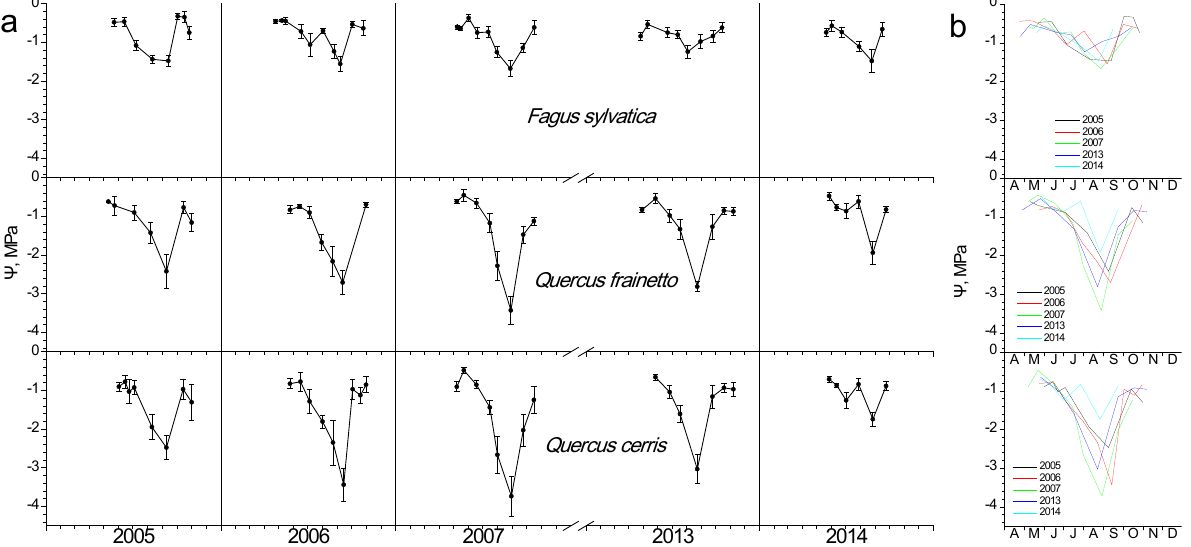
Figure 6. Seasonal fluctuation of leaf water potential ( Ψ ) for the three studied species. ( a ) Data for each year separately (average values ± SD for each date) ( b ) data for all years (only average values per date, error bars are not shown for clarity reasons).